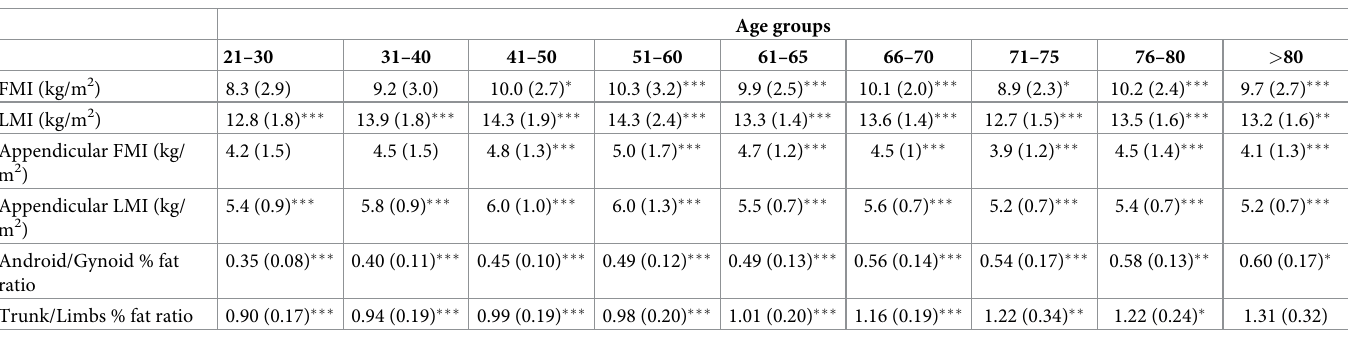
higher indices of body fat distribution (Android/Gynoid % fat ratio and Trunk/Limb % fat ratio) and all parameters associated with lean mass (LM, %LM, LMI, and aLMI) while women had higher indices in parameters associated with fat mass (FM, %FM, FMI, and aFMI) ( p < 0.05; Table 1). Using the LMS method, sex-stratified values for 3 rd , 10 th 50 th , 90 th , and 97 th percentiles for